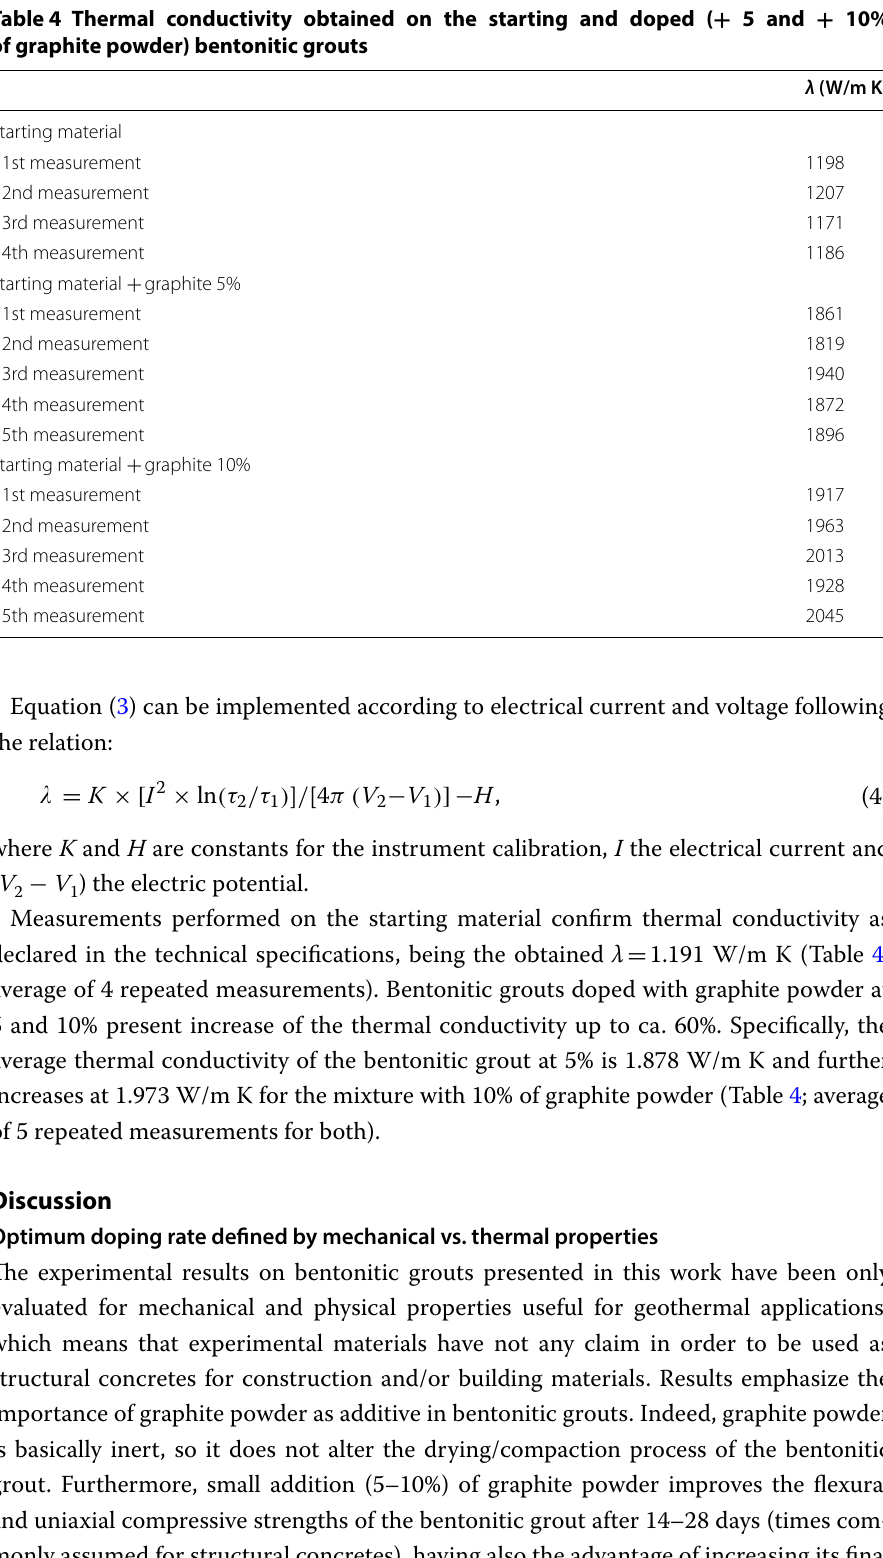
Table 4 Thermal conductivity obtained on the starting and doped ( of graphite powder) bentonitic grouts Starting material 1st measurement